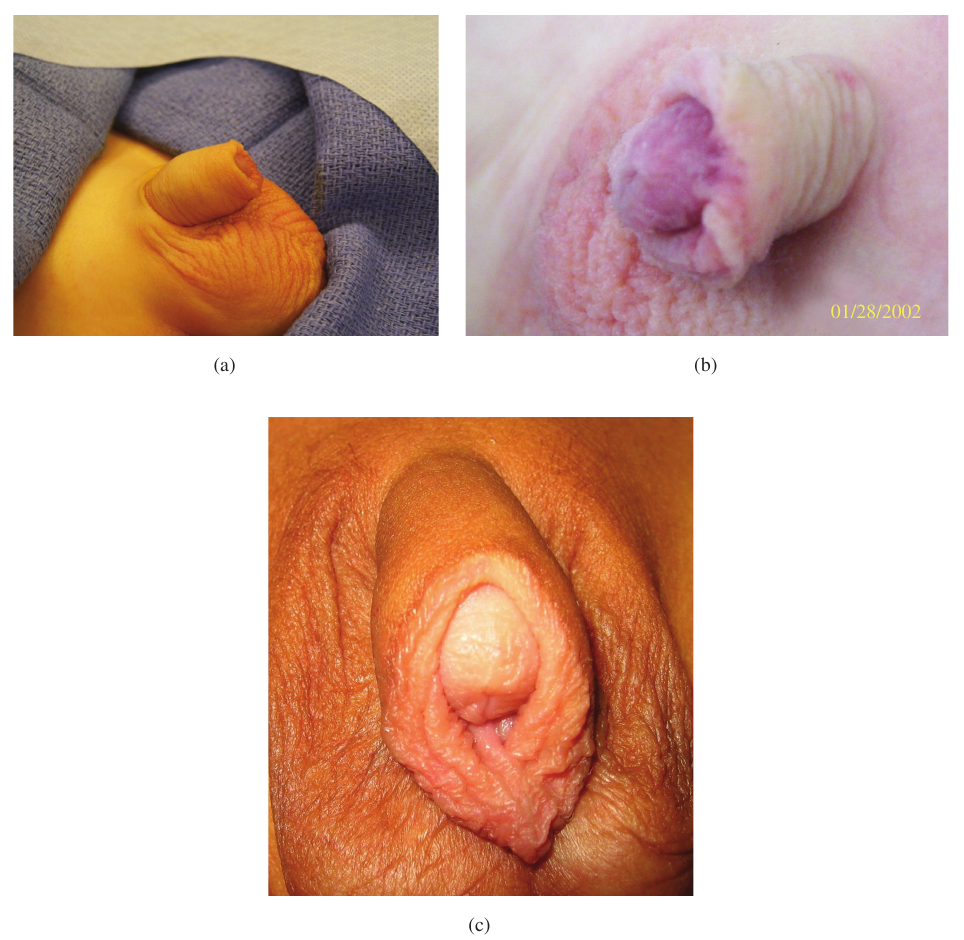
FIGURE 6: Examples of redundant skin following circumcision